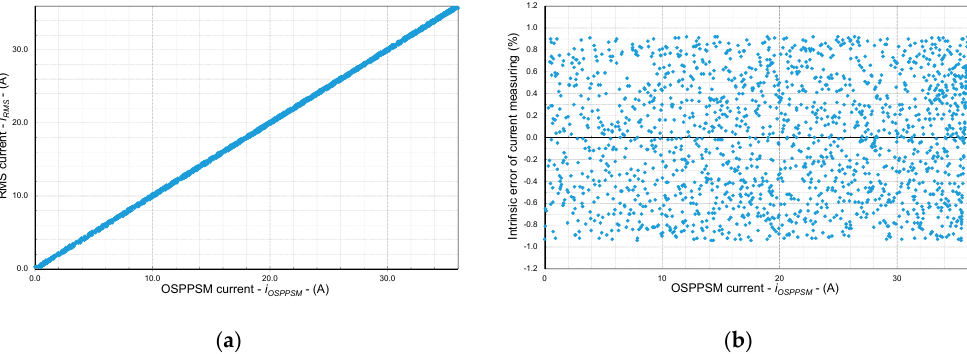
Figure 9. Ammeter test: ( a ) OSPPSM vs. RMS current. ( b ) Intrinsic error of current measuring.